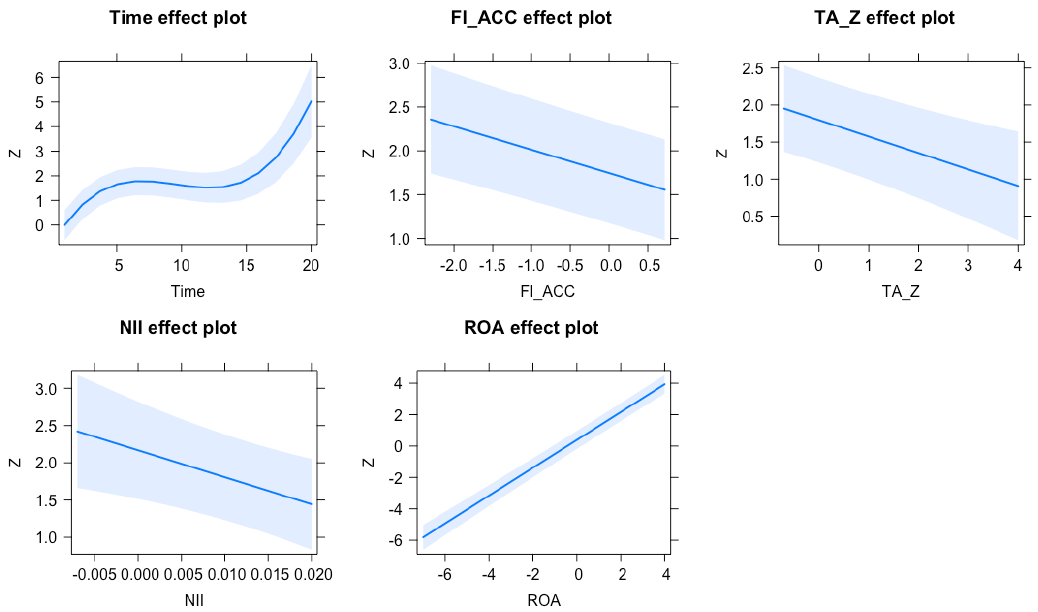
Figure 7. Significant factor effect plots for conventional banks.